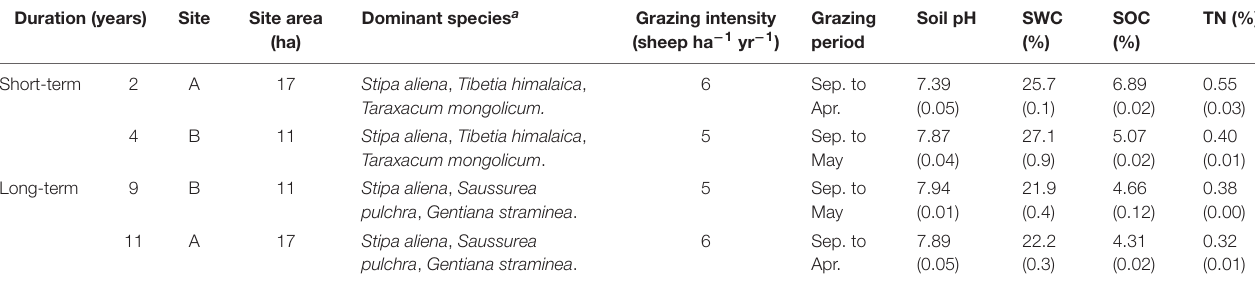
TABLE 1 | Information on the short-term and long-term grazing plots. Numbers in parentheses indicate standard deviation. Duration